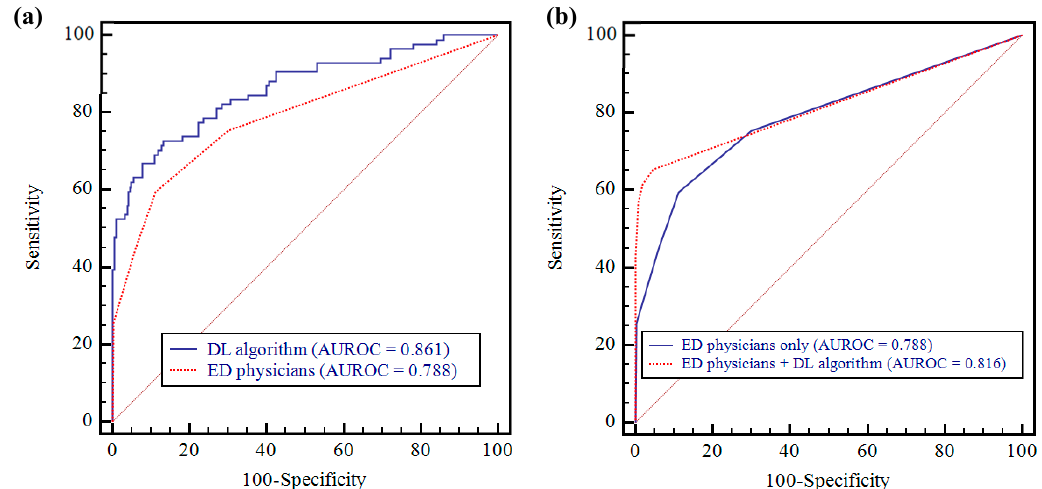
Figure 2. AUROCs of DL algorithm and ED physicians (pneumonia vs. non-pneumonia). ( a ) The DL algorithm showed significantly higher performance than that for ED physicians (0.861 vs. 0.788; p = 0.019). ( b ) ED physicians’ performance was improved after assistance with DL algorithm (0.788 vs. 0.816; p = 0.068). AUROC = area under the receiver operating characteristics curve, DL = deep learning, ED = emergency department.